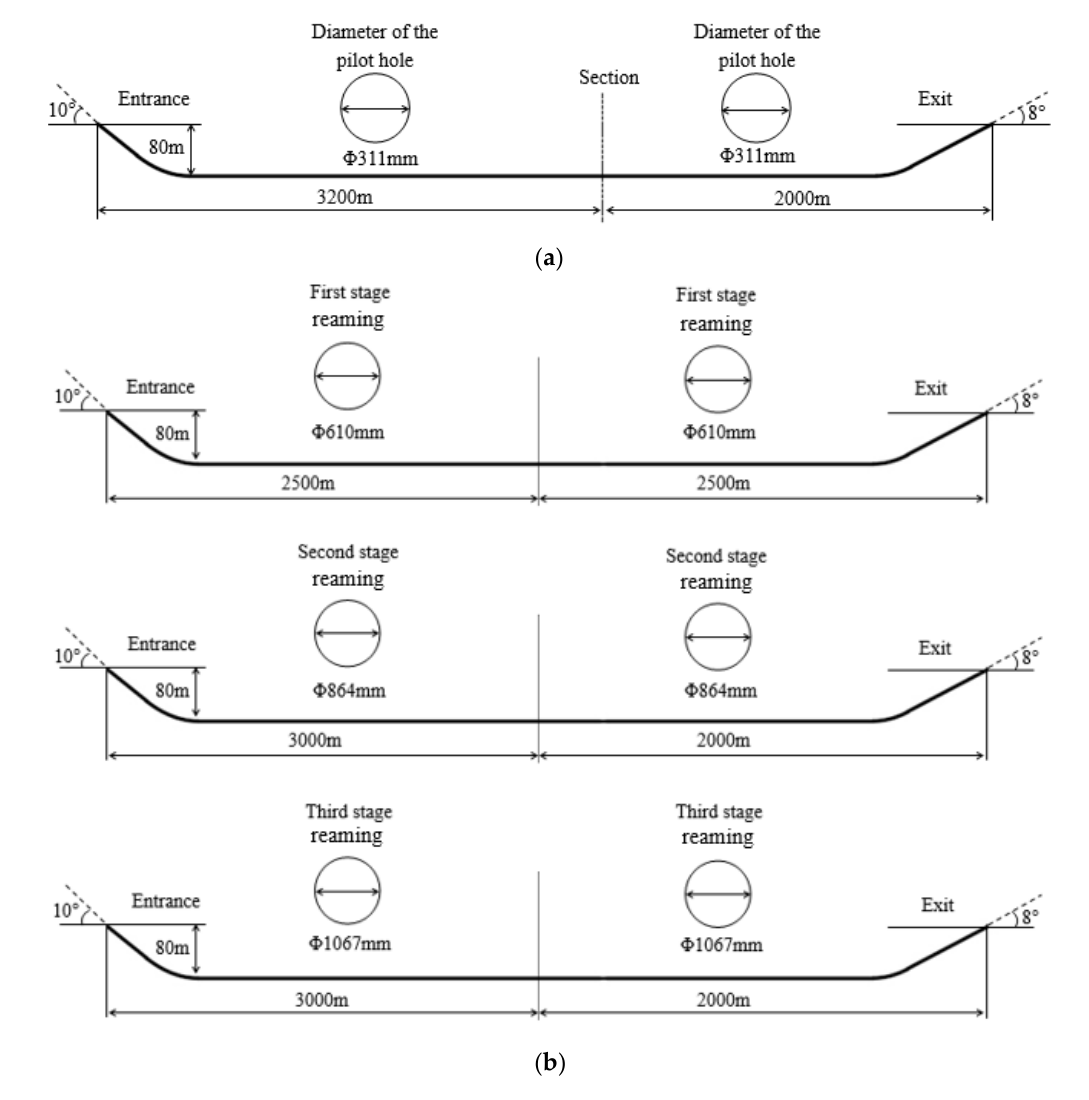
Figure 8. The trajectory and size of the borehole. ( a ) Construction stage of the pilot hole. ( b ) Construction stage of the reaming.